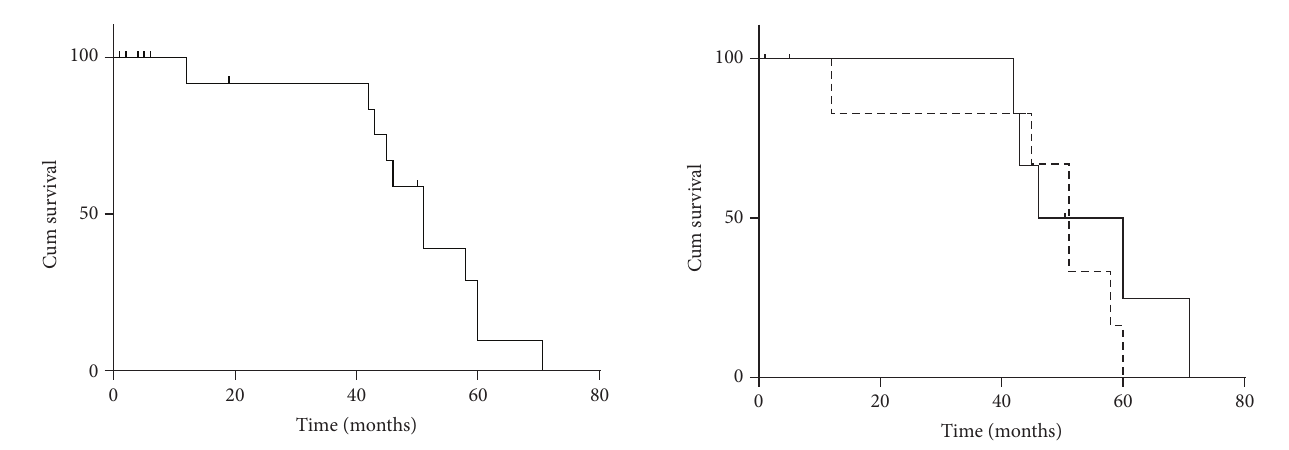
Figure 2: Survival curve for 21 patients with PGSCC. respectively; regional lymph nodes metastases of N1 and N2 occurred in 1 (16.7%) and 2 (33.3%) cases, respectively; stages IIA, IIB, and IV were detected in 1 (16.7%), 1 (16.7%), and 4 (66.6%) patients, respectively.